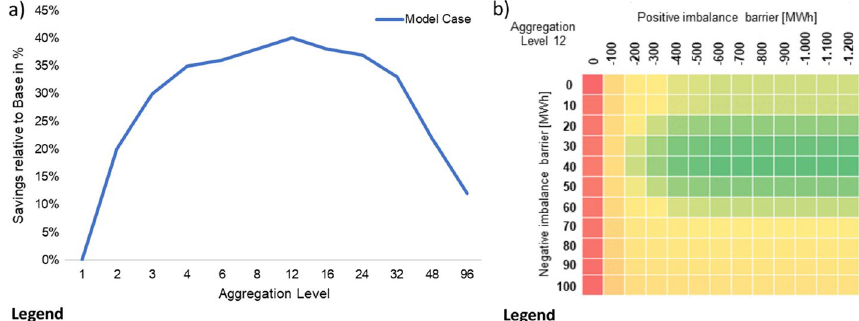
Figure 5 Model savings ( a ) and savings sensitivity to barriers for aggregation level 12 ( b ). Blue line: Model savings relative to Base case and sensitivity to aggregation level. Savings sensitivity to the barrier setting for the aggregation level 12 3 hours ( Base case vs. Model case). Green low deviation, yellow medium deviation, = red high deviation from